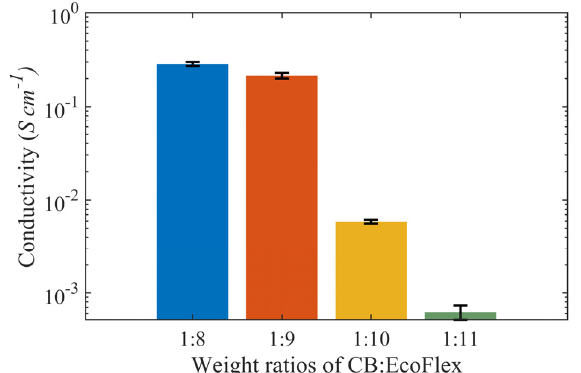
Figure 3. Conductivity measurements across sixteen samples of CB:Ecoflex grouped by different weight ratio percentages.